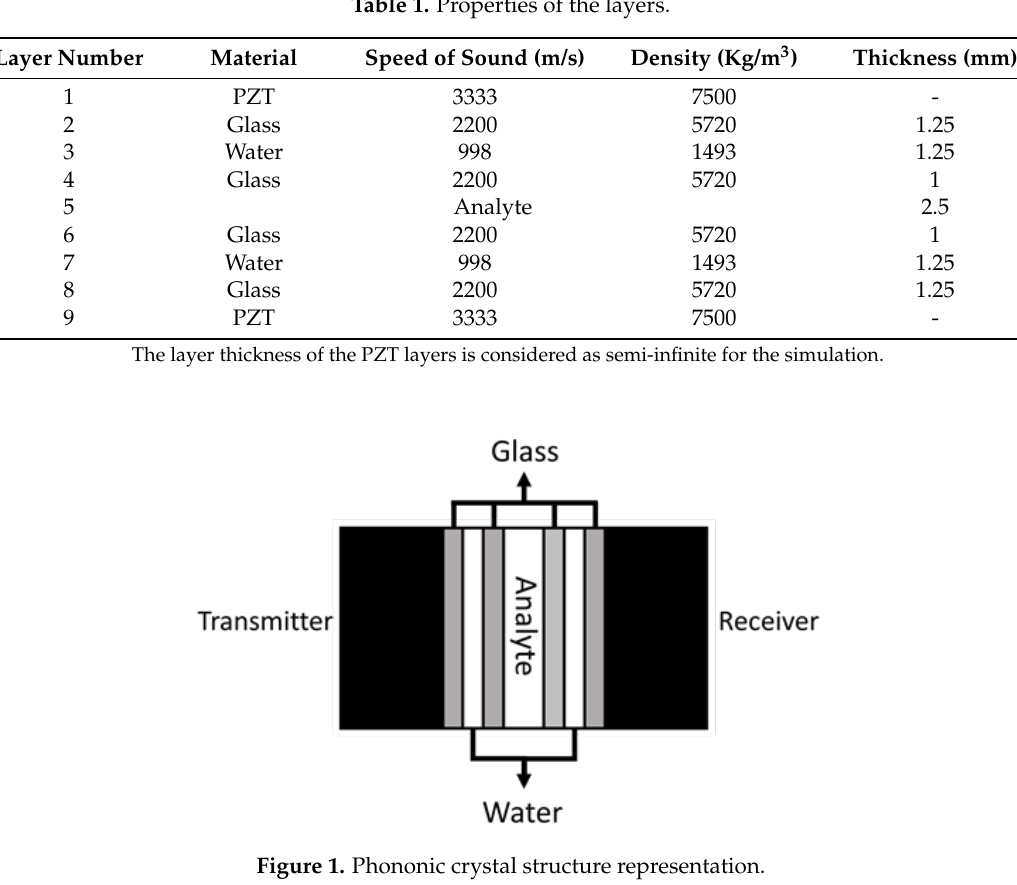
Table 1. Properties of the layers.